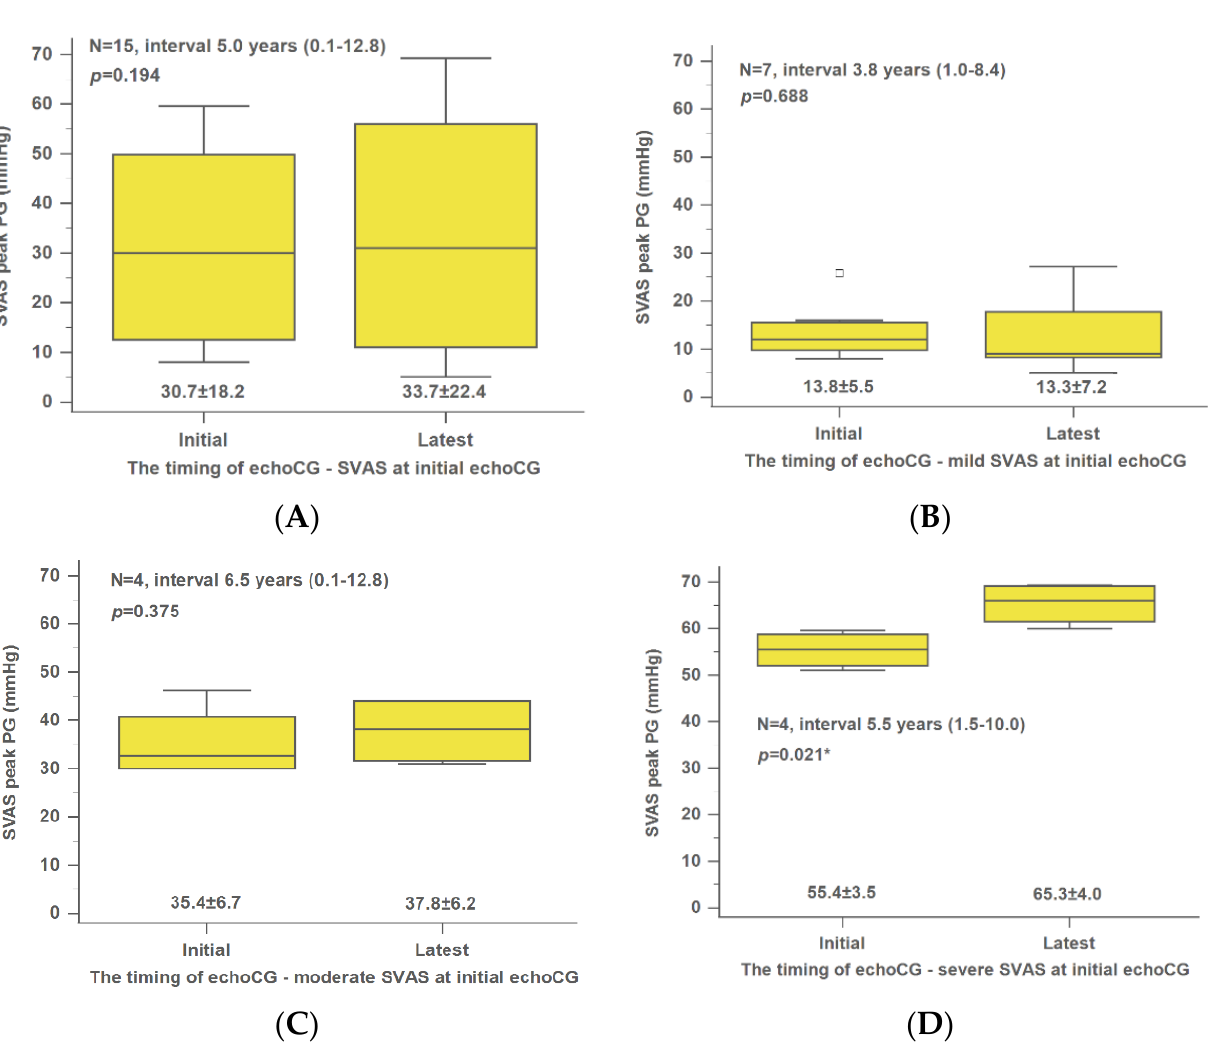
echocardiogram in the cases of SVAS (Figure 3A) and branch PS (Figure 3B). However, no